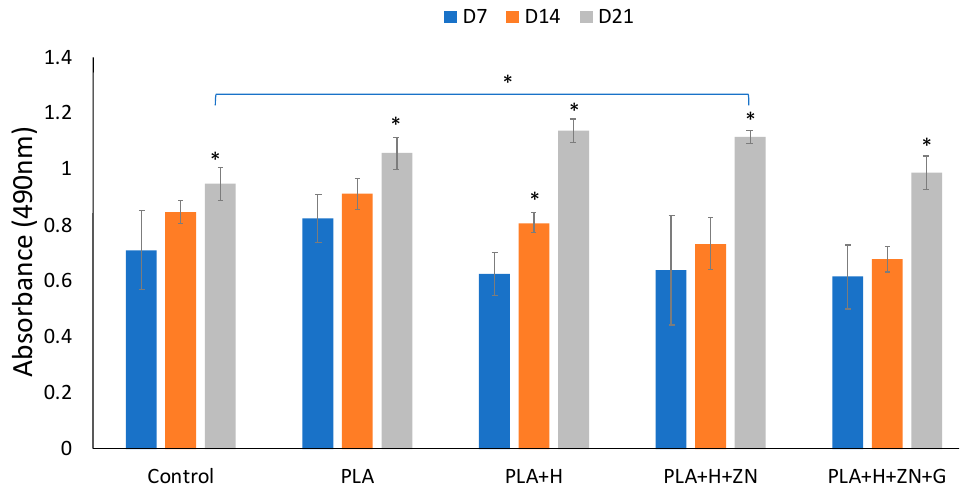
Figure 9. Cell metabolism in 21 days incubation. Cell cultured in monolayer culturing set as control. Then cells cultured with 3D squares consisted of 4 compositions: PLA, PLA added with HNTs (PLA+H), PLA added with zinc-loaded HNTs (PLA+H+Zn), and PLA added with zinc-loaded HNTs and coated with gentamicin (PLA+H+Zn+G). With one-way ANOVA analysis, there is a significant increase in cell metabolism of each group in 21 days. Comparing the cell metabolism in monolayer surface and 3D scaffold groups at day 21, cells cultured in PLA, PLA+H, and PLA+H+Zn had a significant higher cell metabolism than cells cultured in control group (error bar with standard deviation, n = 5, * p < 0.05).